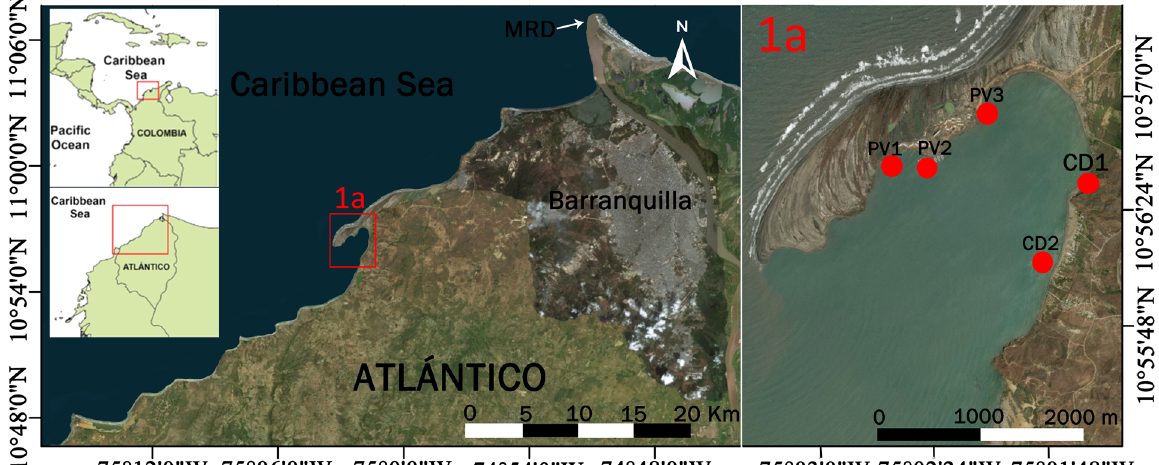
Figure 1. Map of the study area on the shallow shore of the Atlántico Department. 1a: Puerto Velero Bay, PV1 and PV2: Marina, PV3: Puerto Velero beach, CD1 and CD2: Caño Dulce beach. MRD: Magdalena River